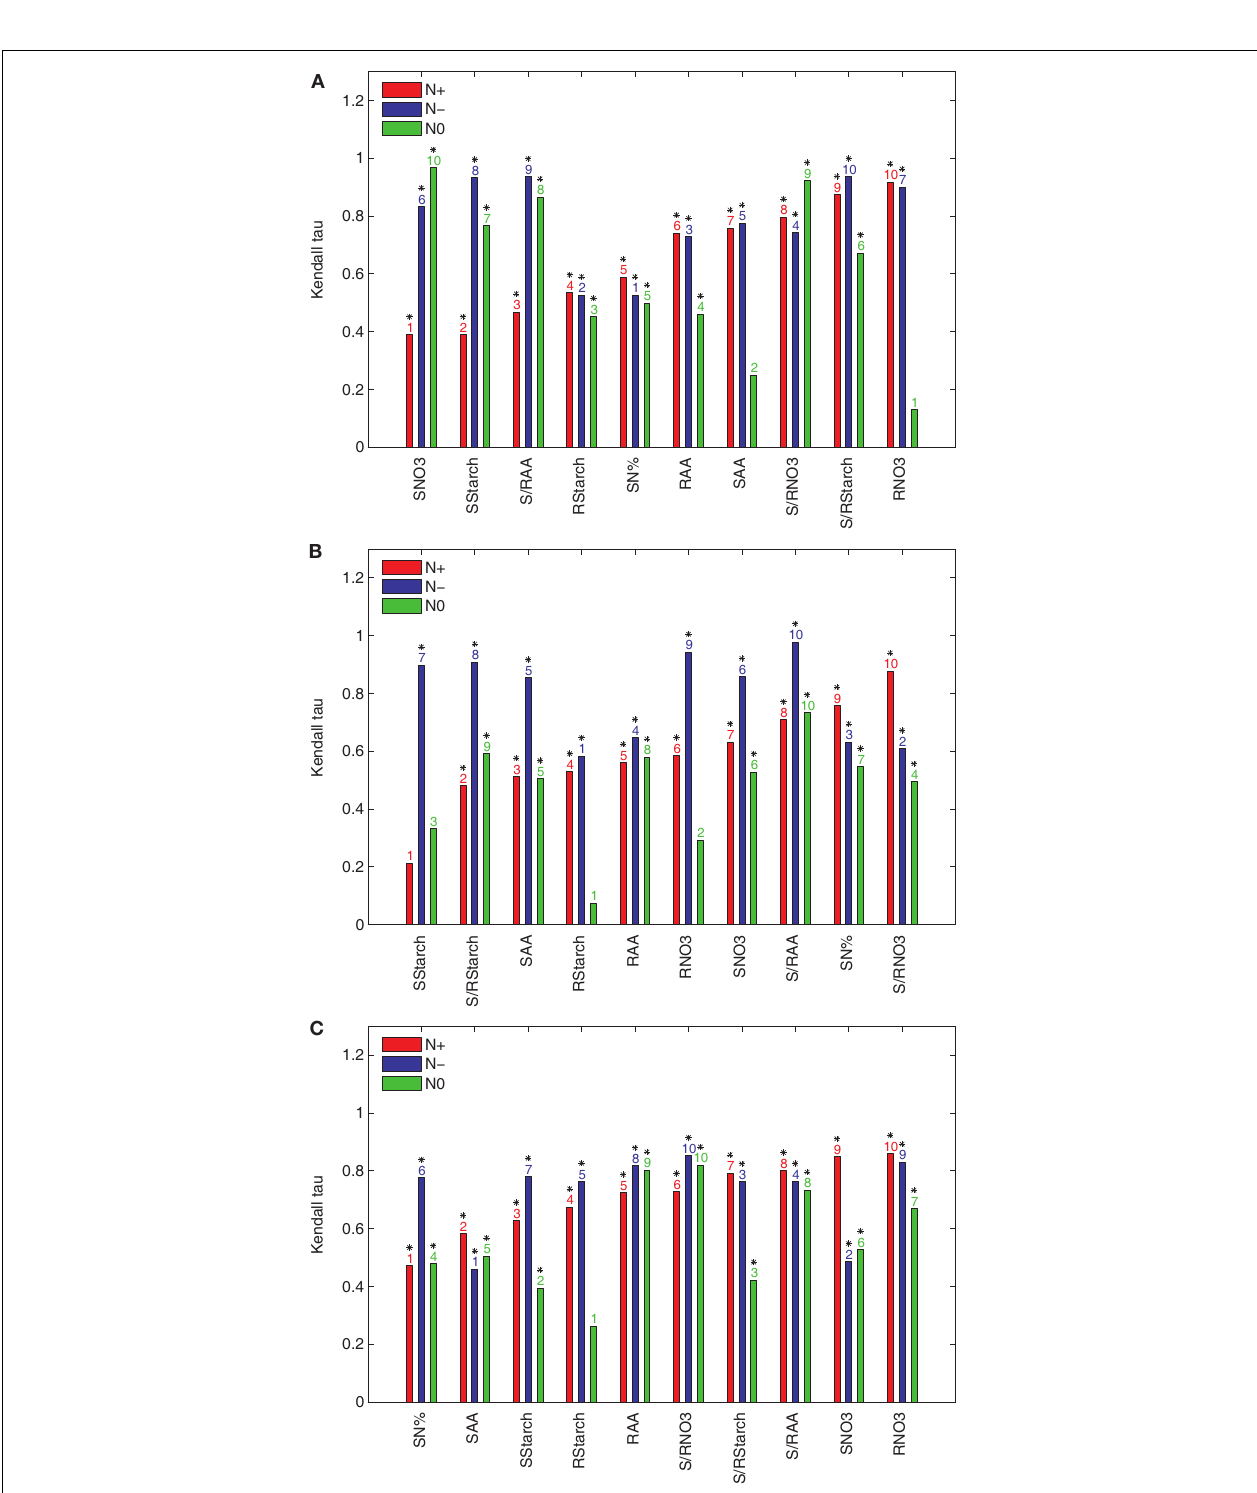
FIGURE 2 | Kendall τ of the results from PCA-DEA with 85, 90, and 95% of variance explained. The Kendall τ coefficients between the rankings of the relative efficiencies for the 23 accessions are obtained from the data sets of the three considered conditions (N + , N − , and N0) with and without a metabolic trait t indicated in the x -axis of each panel when the principal components explaining (A) 85%, (B) 90%, and (C) 95% of the variance are used.The metabolic traits are sorted in an ascending order of the respective